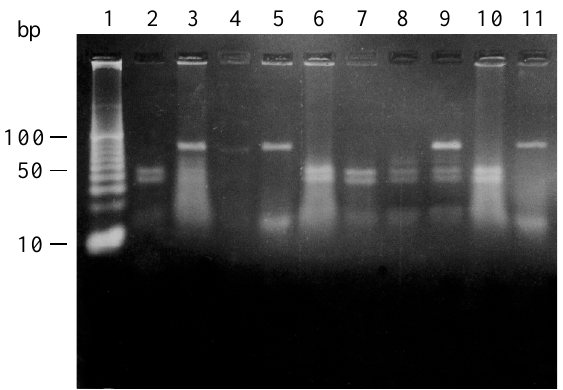
Figure 2 - Electrophoretic profile of PCR products digested with Cfo I. Lane 1 : 10-bp ladder molecular weight marker (GIBCO BRL); lanes 2 , 6 , 7 , 8 , and 10 : normal homozygotes ( NN ) (two Large White pigs, two Landrace pigs, and one Duroc pig); lanes 3 , 4 , and 9 : heterozygotes ( Nn ) (two Landrace pigs and one Pietrain pig); lanes 5 and 11 : recessive homozygotes ( nn ) (two Pietrain